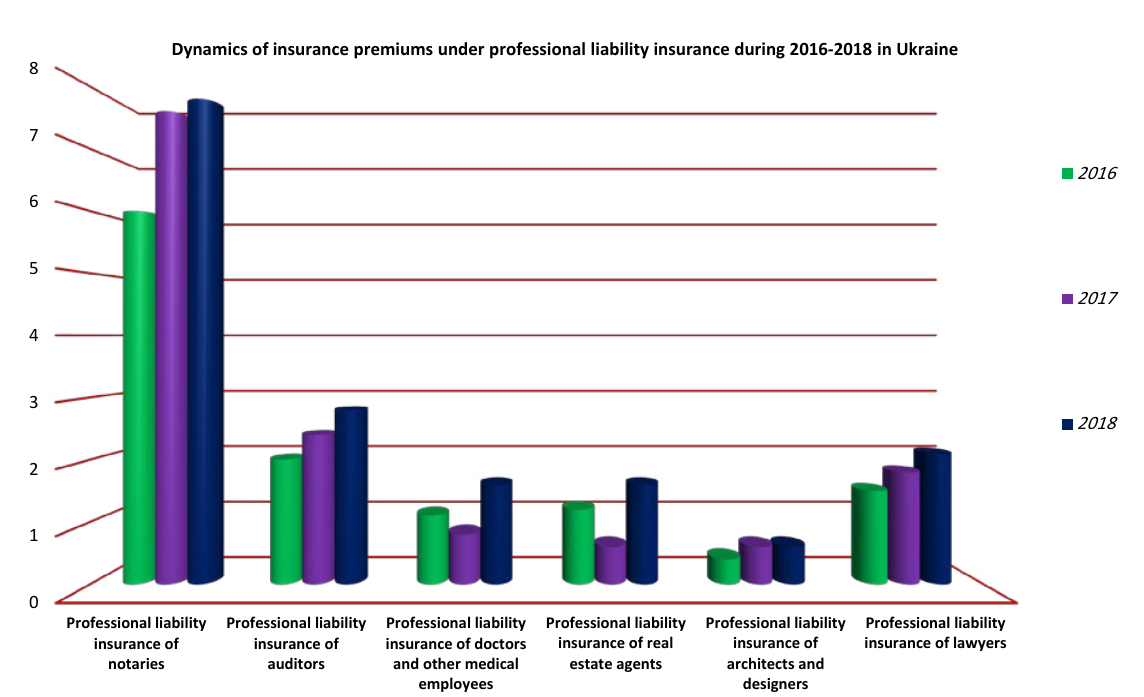
Fig. 3: Dynamics of insurance premiums under professional liability insurance during 2016-2018 in Ukraine